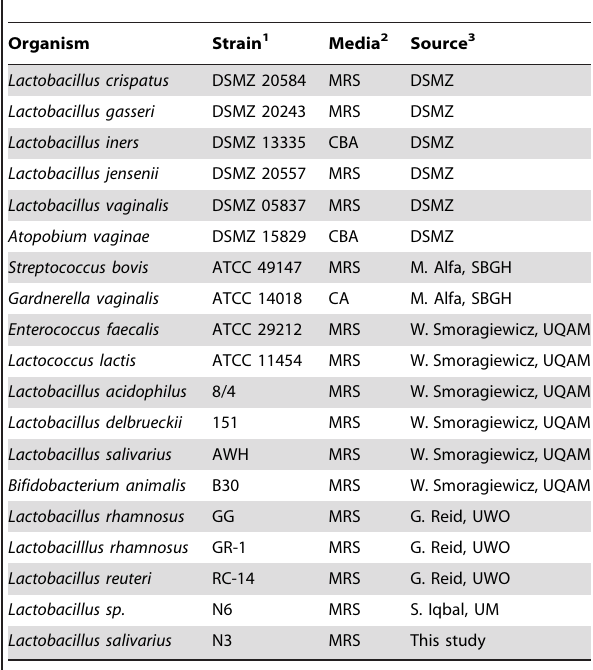
Table 3. Panel of reference